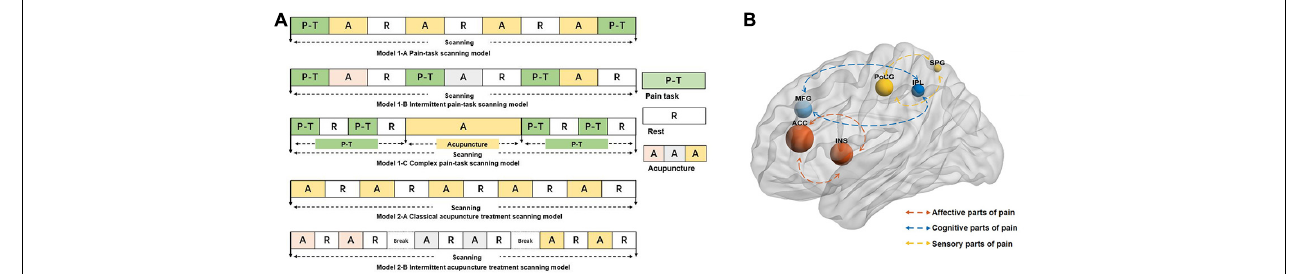
FIGURE 2 | (A) The models of neuroimaging scanning. The different color A represents the different intensity or modality of acupuncture. (B) The reported brain regions in the studies. The size of the nodes represents the frequency the reported brain regions, the different color of the nodes represents the different roles of the process of the pain. The blue nodes mainly represent the role of processing the cognitive parts of pain, the red nodes mainly represent the role of processing the affective parts of pain, and the yellow nodes mainly represent the role of processing the sensory part of pain. ACC, anterior cingulate cortex; INS, insula; MFG, middle frontal gyrus; PoCG, postcentral gyrus; IPL, inferior parietal gyrus; SPG, superior parietal